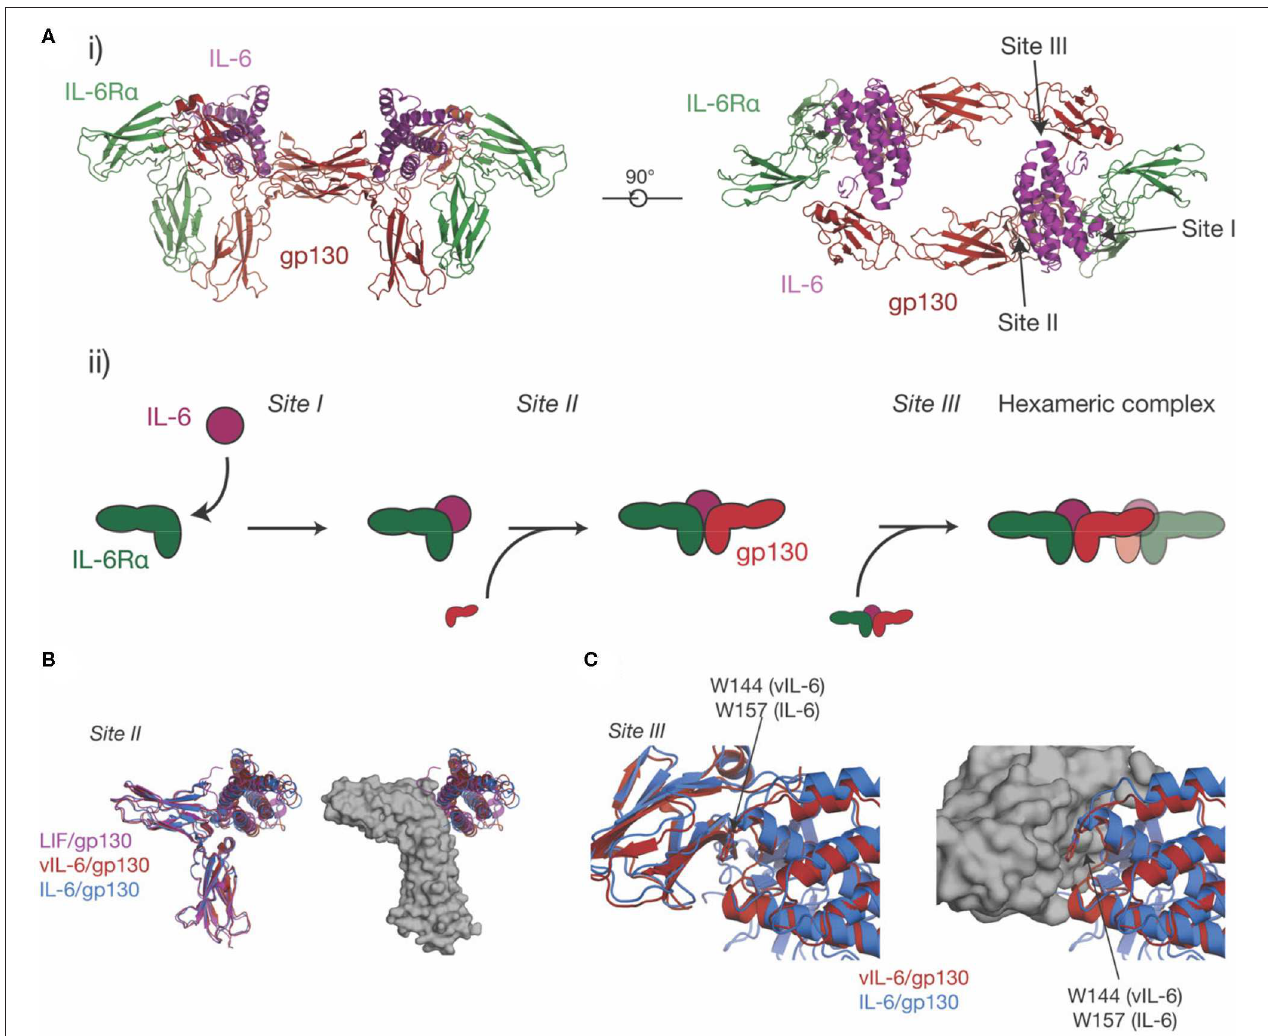
FIGURE 4 | The structure of the IL-6 signaling complex. (A) (i) Two views of the structure of the hexameric IL-6/ IL-6R α /gp130 complex [PDB ID: 1P9M (68)]. The three binding sites on the cytokine (site-I, binding IL-6R α , site-II, binding gp130, site-III binding gp130), are indicated in the figure. The stepwise assembly of the complex is shown in (ii), with the interactions mediated by each of the binding sites indicated. (B) The binding of three IL-6 family cytokines to the CHR of gp130, IL-6, vIL-6 [PDB ID: 1I1R (67)] and LIF [PDB ID: 1PVH (76)]. The three cytokines do not induce significant rearrangements in the CHR of gp130 but adopt a different pose on the CHR and bind different regions in the surface of gp130. (C) The binding of IL-6 and vIL-6 to gp130 D1, the interaction that forms the hexameric complex. The two cytokines engage gp130 D1 in an analogous way. The key tryptophan “hot-spot” residue in site-III is